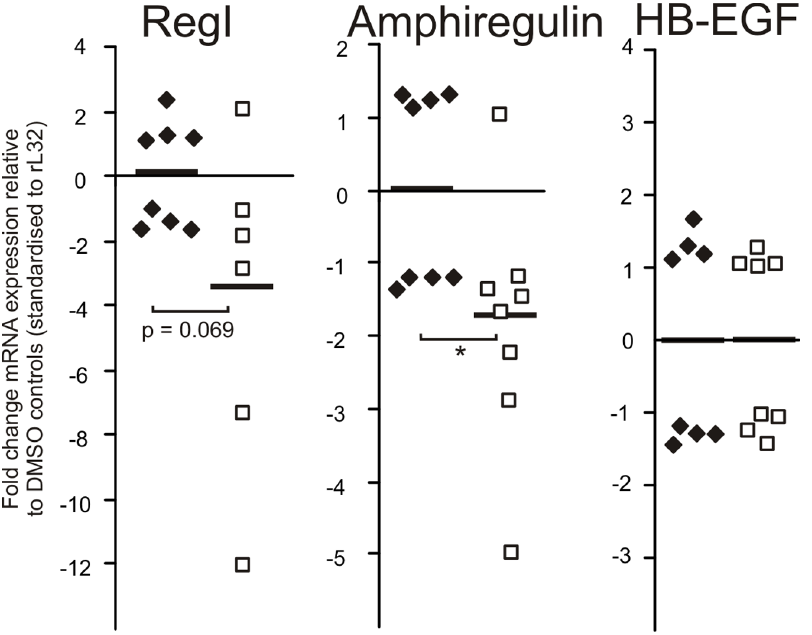
Figure 6. WP1066 treatment of gp130 757FF mice inhibits growth factor expression in the antral mucosa. gp130 757FF mice (8 weeks old) were treated as for Fig. 5. mRNA for Reg1, amphiregulin and HB-EGF were analysed by Q-PCR analysis and quantified by the DD CT method. EGFR ligands were differentially regulated so that amphiregulin mRNA was significantly decreased in the WP1066 treated mice compared to controls (p , 0.05), while HB-EGF was unchanged. The non-EGFR ligand RegI showed a strong trend towards decreased expression (p=0.069). All n=8; *statistically different (p # 0.05).